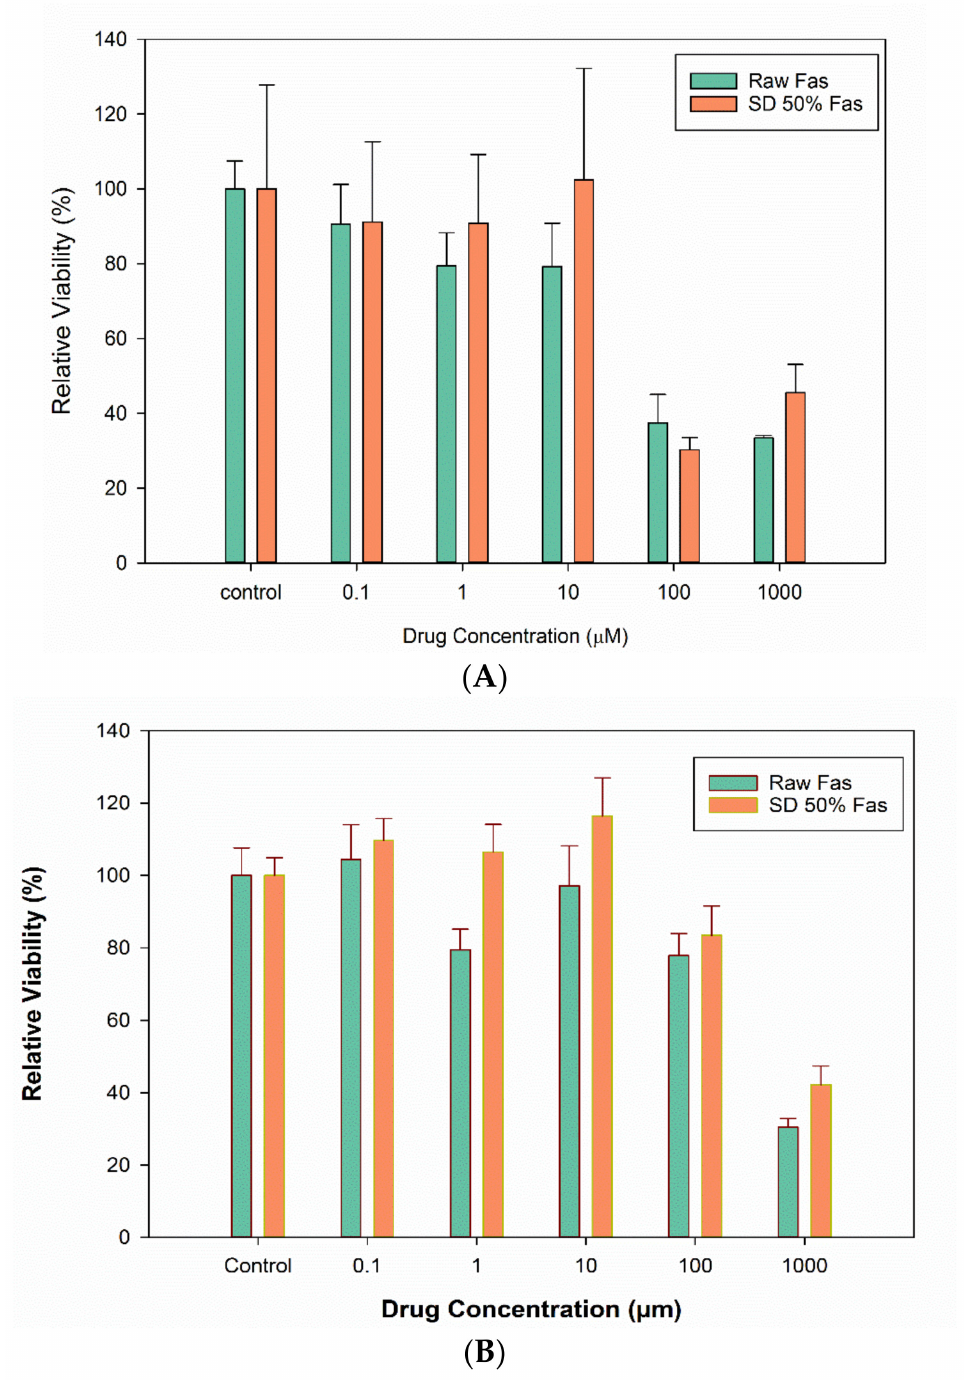
Figure 10. In vitro cell viability of human pulmonary cells exposed to different Fasudil drug concen- trations of raw FAS and selected SD FAS formulations: ( A ). A549 and ( B ). H358 pulmonary cell lines ( n =